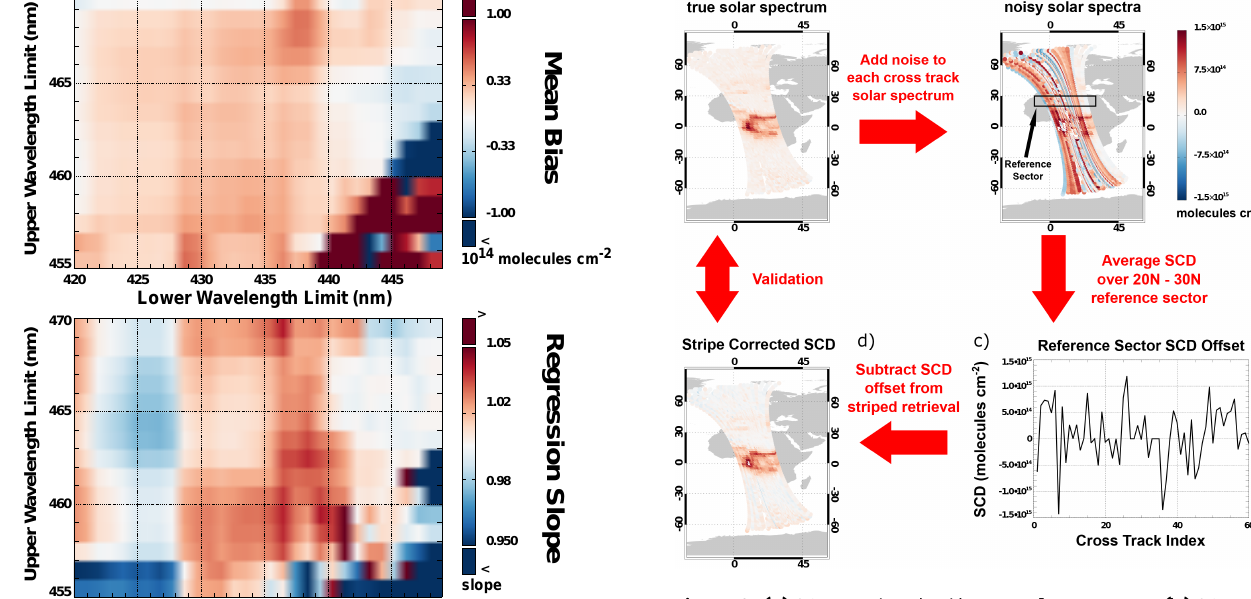
Figure 6. (a) SCD retrieved with true solar spectrum, (b) SCD re- trieved with noisy solar spectra, (c) reference sector SCD offset, (d) stripe corrected SCD.